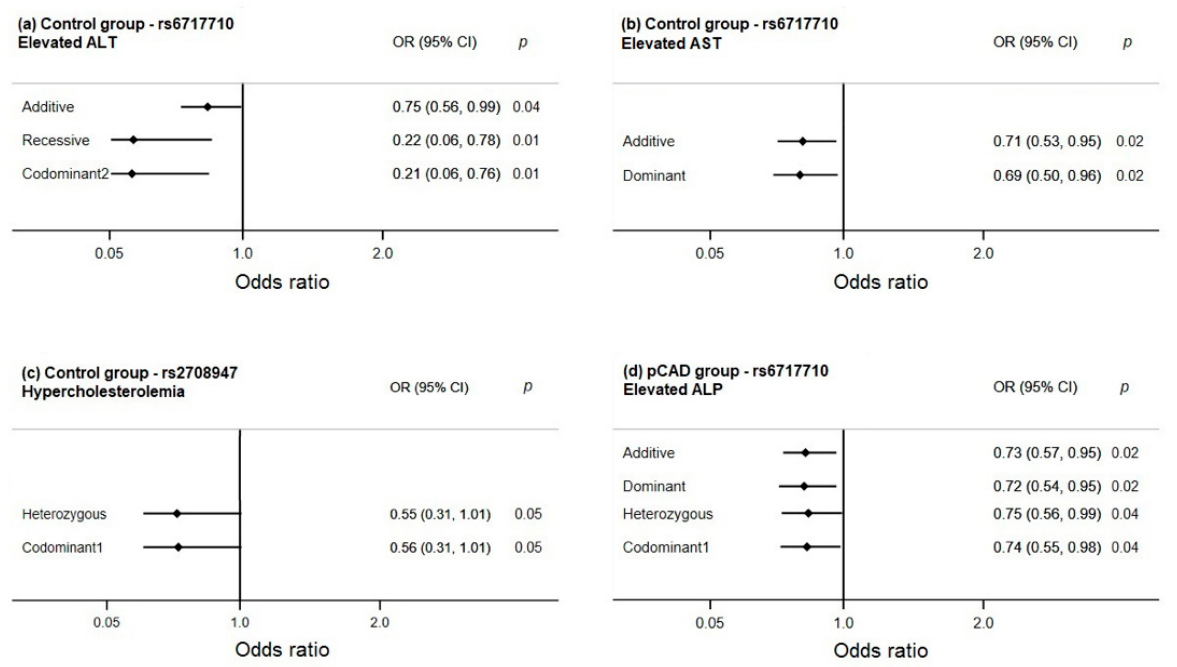
Figure 4. Association of the IL-37 polymorphisms with transaminases and alkaline phosphatase. ( a ) The rs6717710 was associated with low risk of elevated ALT in controls, ( b ) the rs6717710 was associated with low risk of elevated AST in controls, ( c ) the rs2708947 was associated with low risk of hypercholesterolemia in controls, ( d ) the rs6717710 was associated with low risk of elevated ALP in pCAD patients. Models were adjusted by age, sex, BMI, diabetes, LDL-c, hypertension, and smoke. AST: Aspartate aminotransferase; ALT: Alanine aminotransferase; ALP: Alkaline phos- phatase.